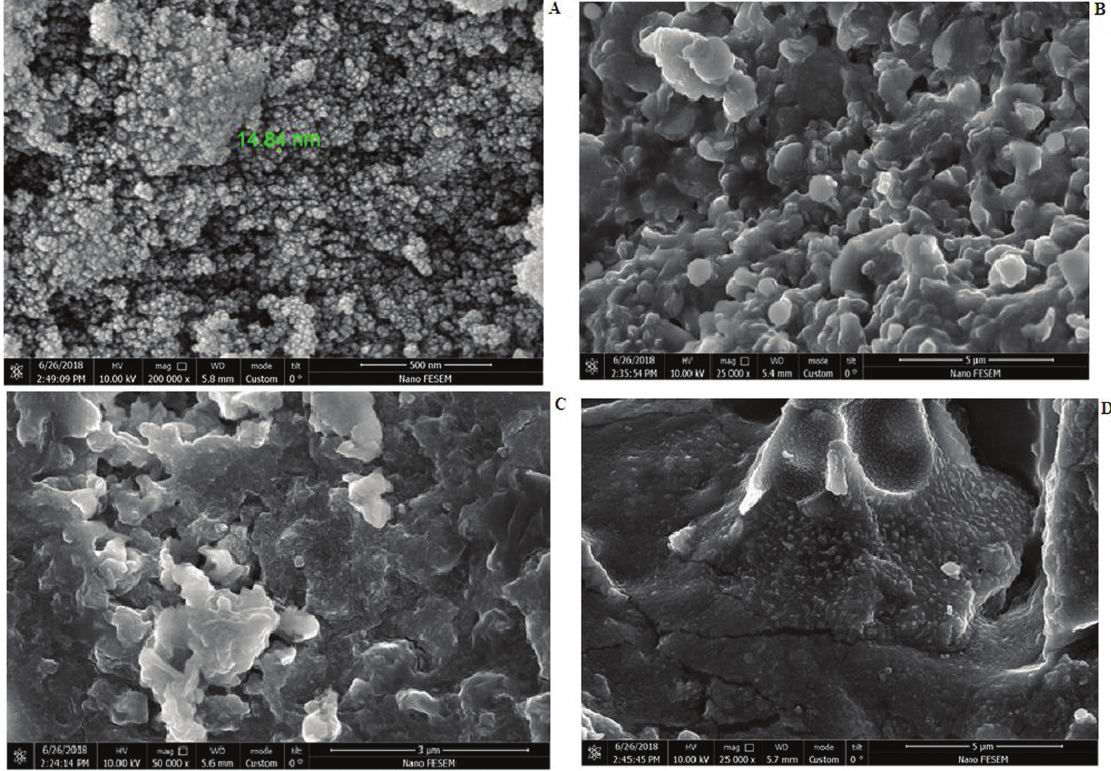
Figure 2: FE-SEM images of Zn 2% w/w (d) of SnFe